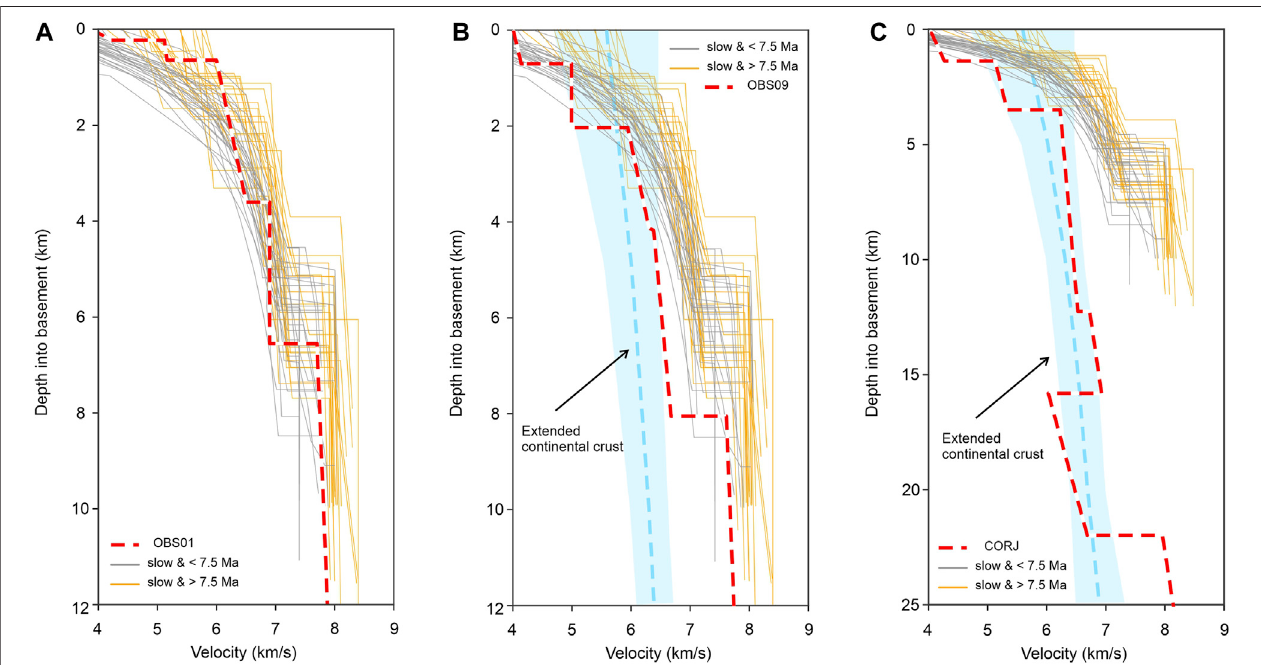
FIGURE9| 1-Dvelocity-depthpro fi lesextractedfromthe fi nalP-wavevelocitymodelatdistancescorrespondingto (A) OBS01(30 km); (B) OBS09(130 km),and (C) CORJ (210 km). We compare our velocity pro fi les with the range of typical velocity pro fi les for “ young ” and “ old ” oceanic crusts formed at slow-spreading centers (grey and orange 1-D pro fi les from Christeson et al. (2019) and extended continental crust (blue line, from Christensen and Mooney, 1995) with its uncertainty (light blue region).